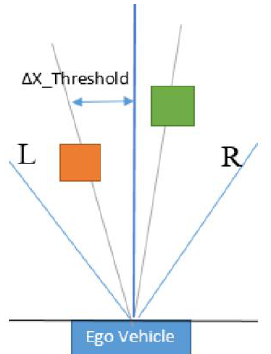
Figure 5. Corresponding objects in the left half (orange) and the right half (green) spaces.